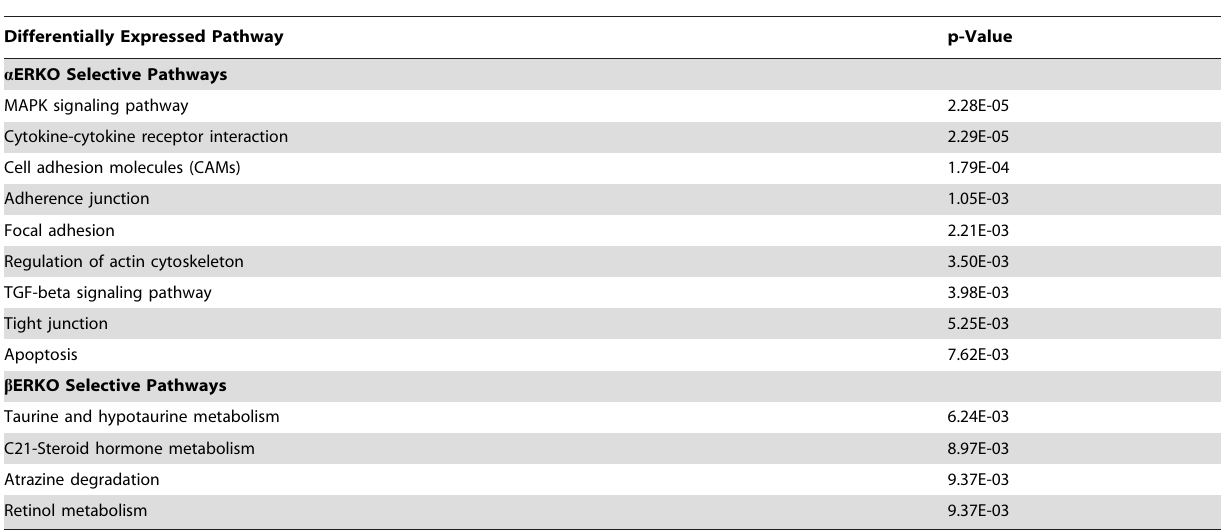
Table 2. Analysis of EGF dependent a ERKO and b ERKO selective pathways in mouse mammary gland organ culture.